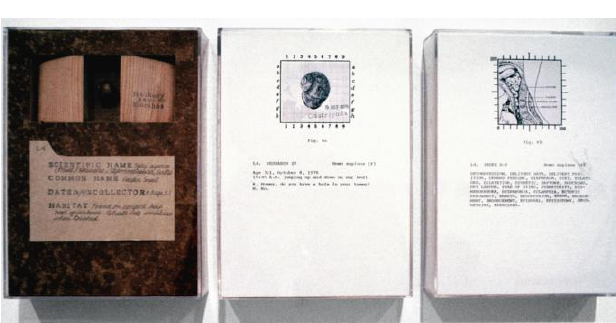
Figure 7: Mary Kelly Post-Partum Document, Documentation V, Classified Specimens, Proportional Diagrams, Statistical Tables, Research and Index, 1977, (detail, 3 of 33)